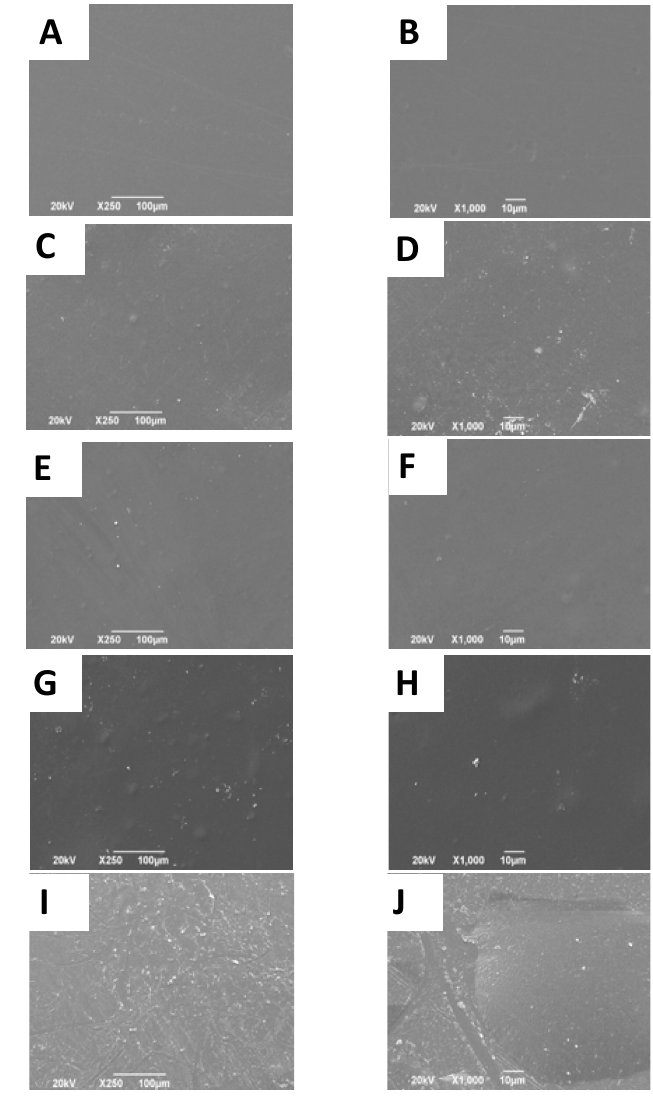
Figure 4. Morphology of the films: F1 (30 CS/70 PVA/0 ox-CNO) ( A ) at 250×, ( B ) at 1000×; F2 (29.75 CS/70 PVA/0.25 ox-CNO) ( C ) at 250×, ( D ) at 1000×; F3 (29.50 CS/70 PVA/0.50 ox-CNO) ( E ) at 250×, ( F ) at 1000×; F4 (29.25 CS/70 PVA/0.25 ox-CNO) ( G ) at 250×, ( H ) at 1000×; F5 (29.00 CS/70 PVA/1.00 ox-CNO), ( I ) at 250×, (J) at 1000×.